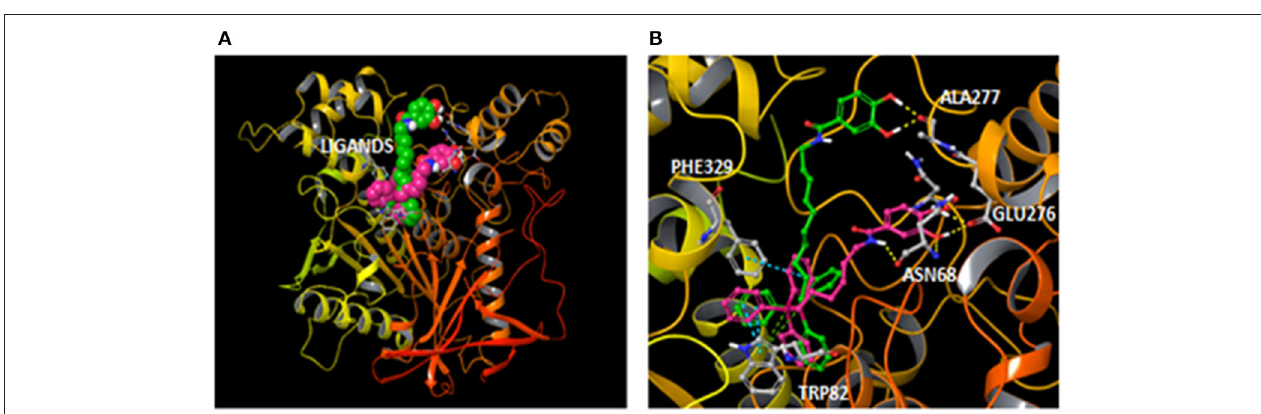
FIGURE 7 | (A) General overview with compounds AntiOxBEN 1 and 17 (pink and green carbons respectively) bound to BChE after docking simulations; and (B) Comparison of the hypothetical binding modes determined for compounds AntiOxBEN 1 (pink carbons) and 17 (green carbons) inside the BChE (color code: yellow dashes for hydrogen bonds, blue dashes for π - π stacking interactions and green dashes for π -cation